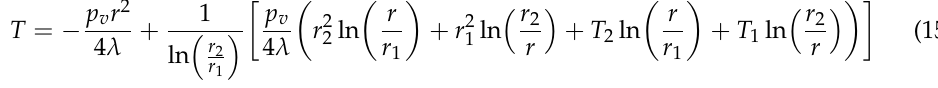
Figure 8. Heat conducting cylindrical wall.